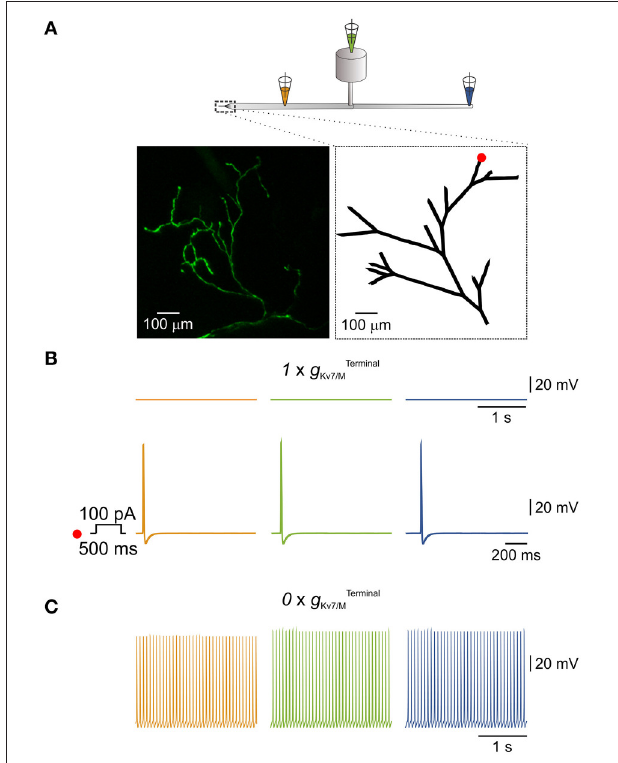
FIGURE 4 | I M in the terminals is sufficient to prevent spontaneous activation of a simulated multi-compartment nociceptive neuron. (A) Scheme depicting the general structure of the multi-compartment model. Dotted box outlines the nociceptive terminal, enlarged in the right inset below. Orange, green, and blue pipettes indicate the sites from which the changes in membrane potentials were recorded and correspond to: peripheral axon ( orange ), soma ( green ), and central axon ( blue ). Insets , Left, in-vivo multiphoton imaging of nociceptive peripheral terminals and distal axons in the mouse hind paw expressing GFP (z-stack; see Methods). Right, geometry of the terminal tree based on the rendering of the image shown in left which was used in the NEURON environment to simulate nociceptive peripheral terminals and distal axons. The red dot indicates the stimulus loci. (B) Upper traces , recordings from peripheral axon ( orange ), soma ( green ), and central axon ( blue ) when terminal K v 7 conductance (g Terminal Kv7 / M ) was intact (1 xg Terminal Kv7 / M , see Methods). Note, no spontaneous action potential firing, yet application of 100 pA depolarizing current for 500ms at the distal terminal branch (indicated as a red dot in A , inset, right ) lead to generation of a single action potential which propagated along the neuron. (C) Annulling of g Terminal Kv7 / M (0 x g Terminal Kv7 / M ) lead to generation of spontaneous action potential firing at the distal axons ( orange ) which fully propagated along the neuron ( green and blue